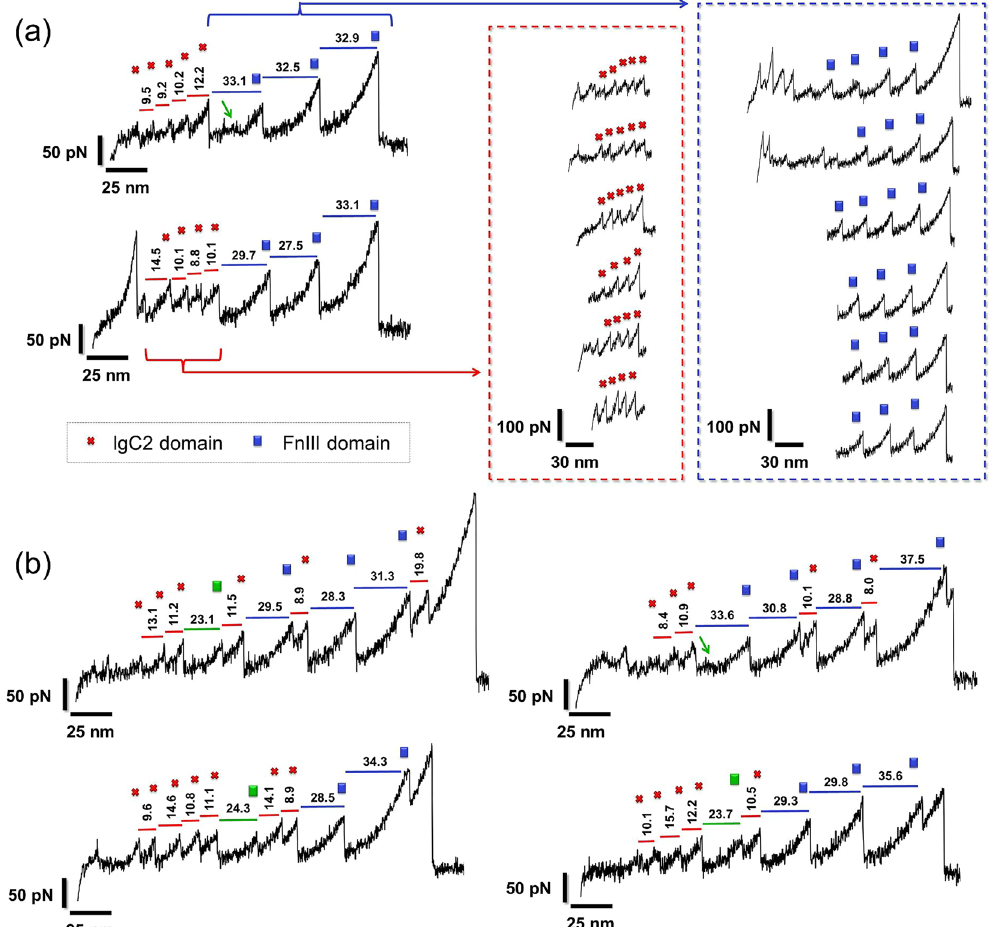
Figure 2. Typical force-extension curves with saw-tooth patterns observed for CNTN4 in smFS AFM. Red crosses and blue rectangles indicate unfolding patterns associated with the respective domains IgC2 and FnIII. Displayed numbers (in nm) above each peak are the unfolding length resulting from WLC model fitting. Green arrow points a characteristic hump which appears in FnIII modules. ( a ) Examples of force-extension profiles with sequential unfolding of short (red crosses) and long (blue rectangles) elongations are displayed in red and blue boxes (right side); ( b ) Example of non-sequential unfolding of short and long elongations with at least 9 unfolding peaks. Green square indicates an event that most probably arises from alternative unfolding of FnIII1